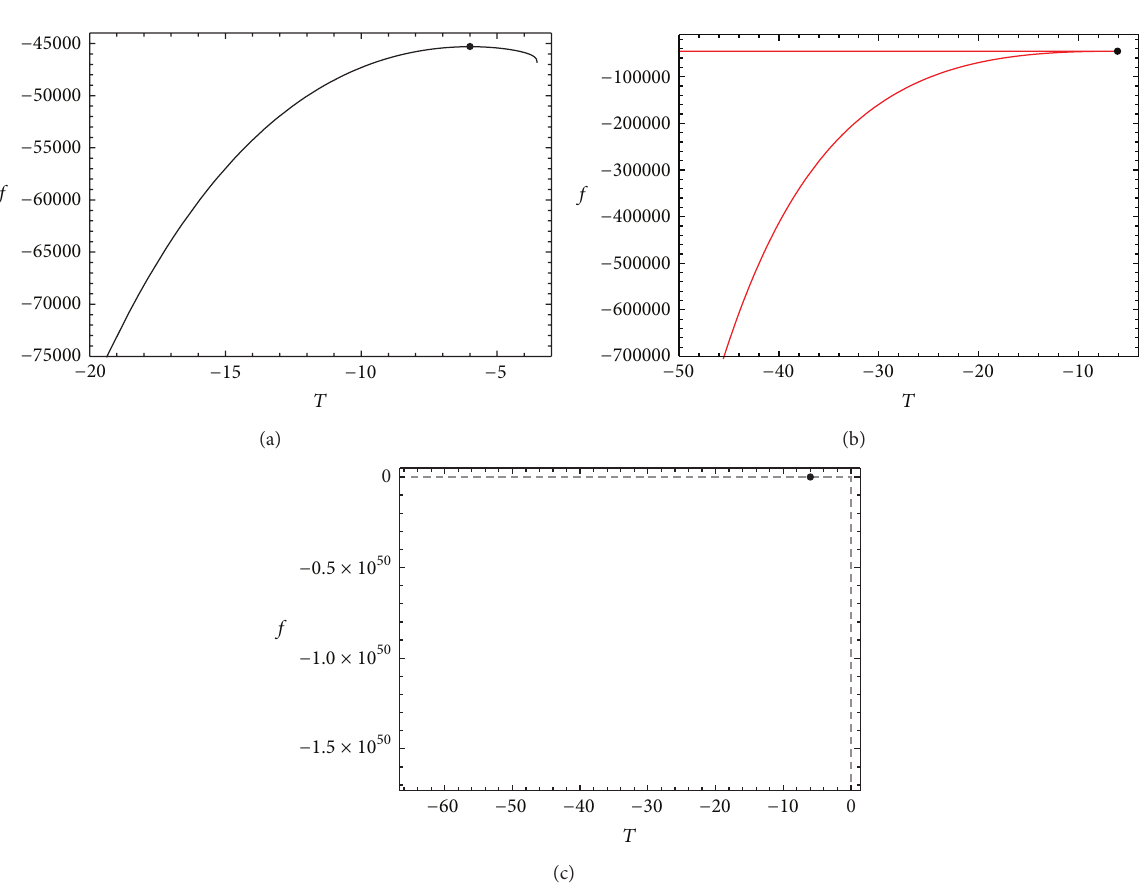
Figure 7: Future evolution of 𝑓(𝑇) for HDE with Ω 𝑚0 = 0.315 , 𝐻 0 = 67.3 , and −1 ⩽ 𝑧 ⩽ 1 . The dot denotes the present day value of the function 𝑓(𝑇)